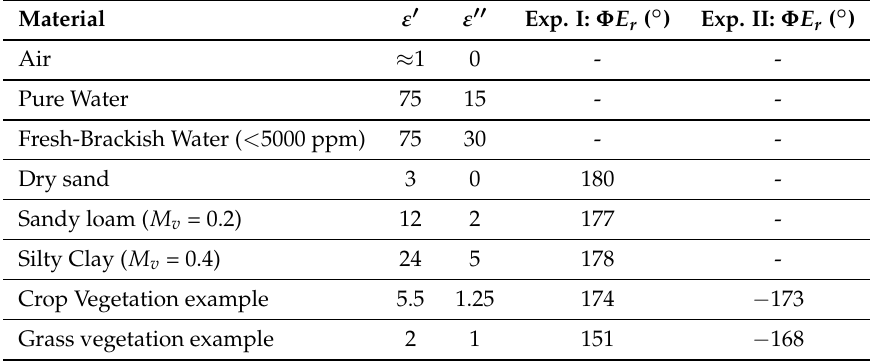
Table 1. The model and all experiments were coded in the Matlab R (cid:13) 2018b coding software, with all scripts available as open data (see Supplementary Materials). Table 1. Approximate dielectric properties ε r for some of Earth’s materials at normal pressure and temperature [31–37] and results of experiments I and II. M v is soil moisture with unit m 3 m − 3 .